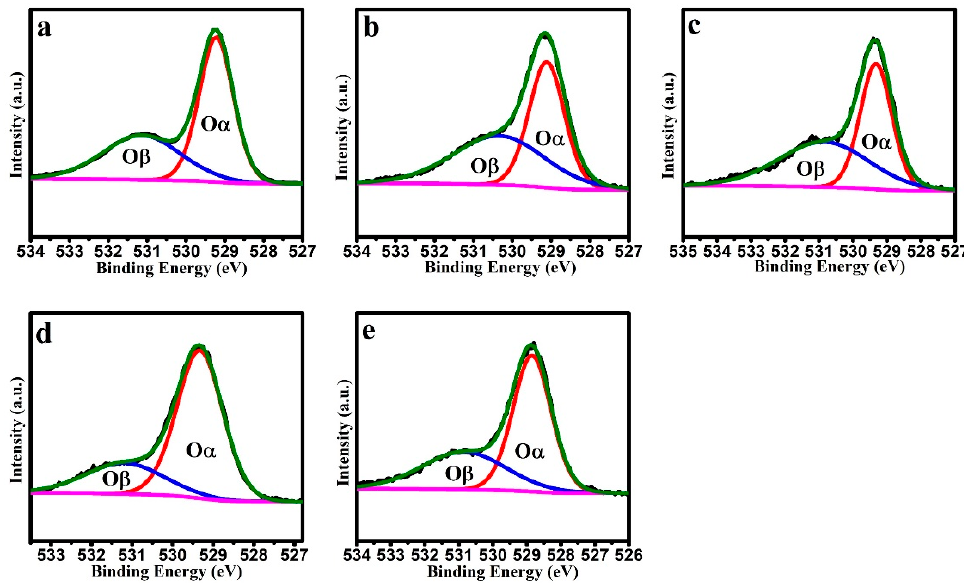
Figure 5. O1s spectra of various CeO 2 nanomaterials ( a ) 2MCeO 2 np, ( b ) 6MCeO 2 nr, ( c ) 12MCeO 2 nr, ( d ) 6MCeO 2 nc, and ( e ) 12MCeO 2 nc, red peak is attributed to O α , blue peak is attributed to O β .